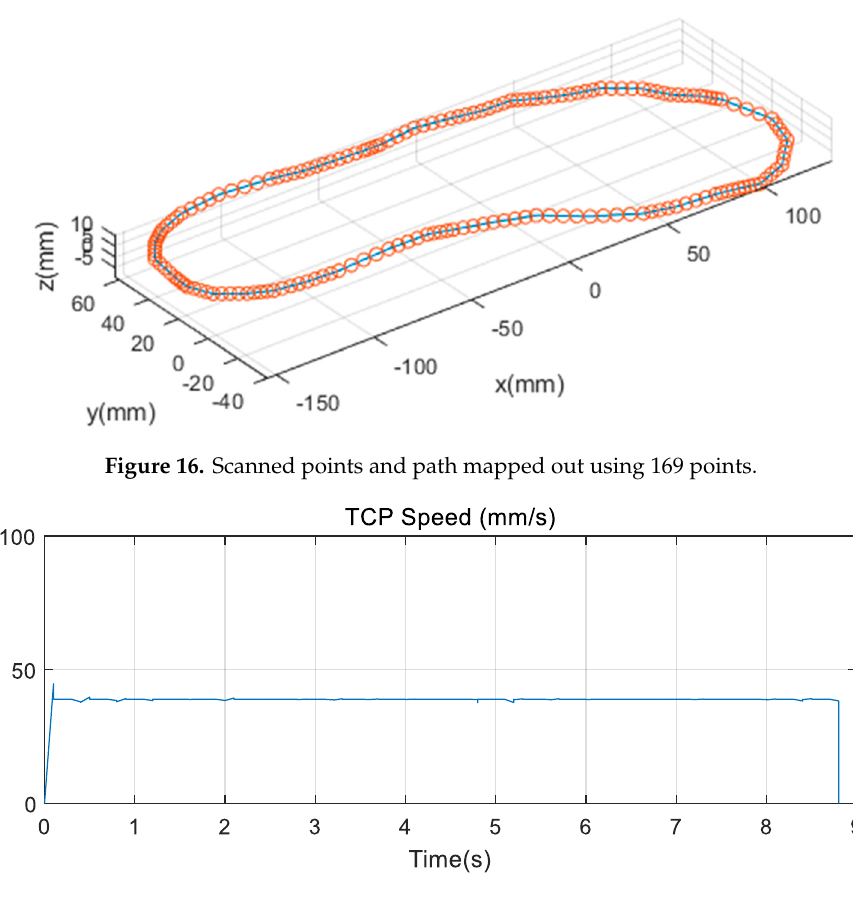
Figure 17. TCP speed in the trajectory using 169 points.